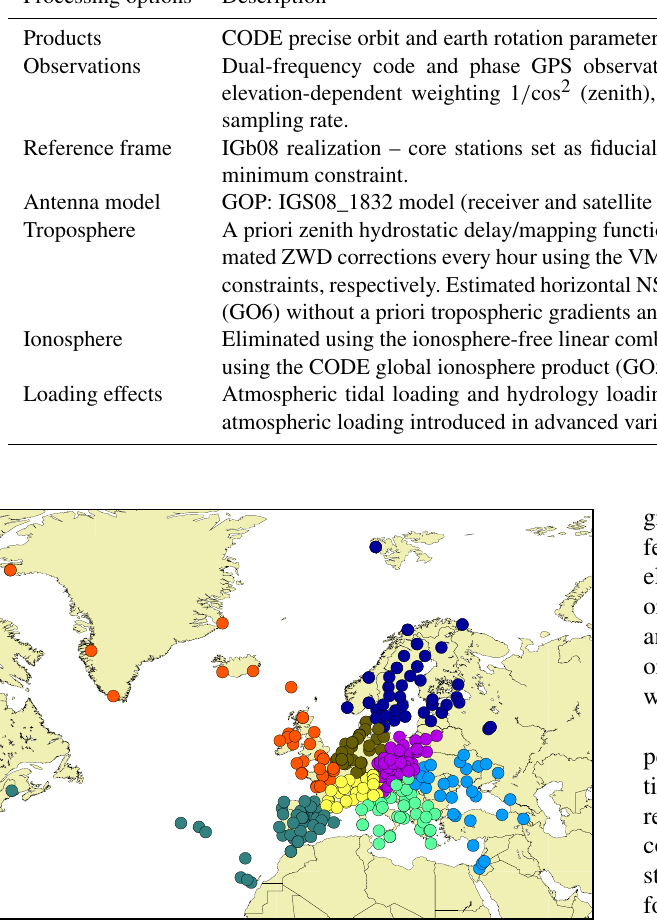
Figure 1. EUREF Permanent Network’s clusters (designated by dif- ferent colours) in the second GOP